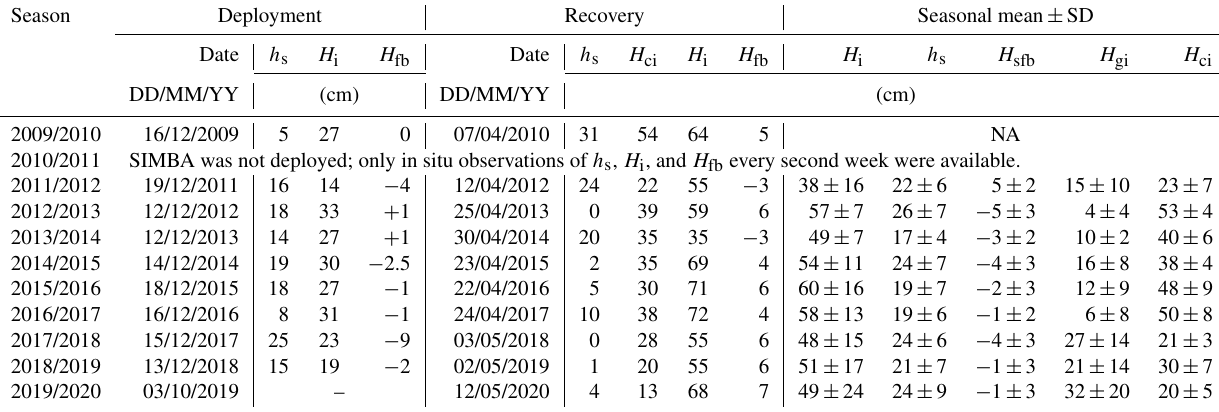
The seasonal mean values of H i , h s , H gi , and H ci were calculated by the SIMBA algorithm (Cheng et al., 2020). The seasonal mean value of ice freeboard ( H sfb ) was calculated based on time series of snow depth ( h s ), granular ice thickness ( H gi ), and columnar ice thickness ( H i ) according to Archimedes’ principle: H sfb = H i + H gi − ( h s ρ s + H gi ρ gi + H i ρ i ) /ρ w , where ρ s , ρ gi , ρ i , and ρ w are seasonal mean densities of snow, granular ice and columnar ice, and lake water, assumed to be 320, 890 and 910, and 1000kg/m 3 , respectively.